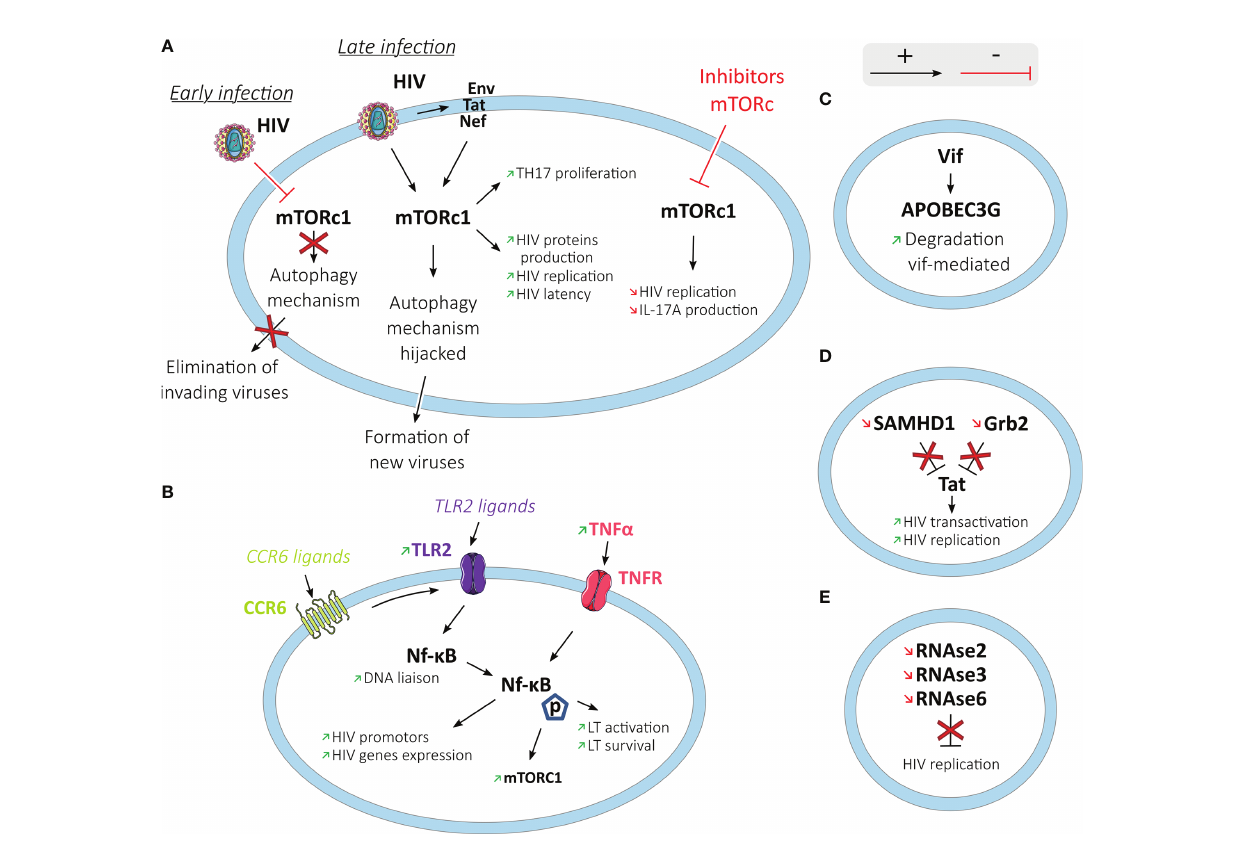
FIGURE 4 | HIV post-entry process and replication in Th17 cells. Th17 cells and HIV have different interactions (activating in black arrows and inhibiting in red arrows) to promote HIV replication in these cells. (A) In the mTOR pathway: at an early stage of the infection, HIV stops the autophagy mechanism directed by mTORc1 to block the elimination of invading viruses. At a later stage, HIV interacts with mTORc1 to hijack the autophagy mechanism to help form new viruses. By interacting with HIV or its proteins (Env, Tat, or Nef), mTORc1 also increases Th17 proliferation, HIV protein production, HIV replication, and latency. (B) by interaction with NF- k B: increased production of TNF a and TLR2 ligation increase in Th17 cells NF- k B translocation and activity, leading to increased HIV replication. Increased NF- k B activity also increases the activity of the mTORc1 pathway and the activation and survival of T cells. (C) Th17 cells exhibit Vif- mediated degradation of the HIV restriction factor, APOBEC3G. (D) SAMHD1 and Grb2 are downregulated in Th17 cells, allowing increased HIV transactivation and replication. (E) RNase2, RNAse3, and RNAse6 genes known to inhibit viral replication are downregulated in Th17